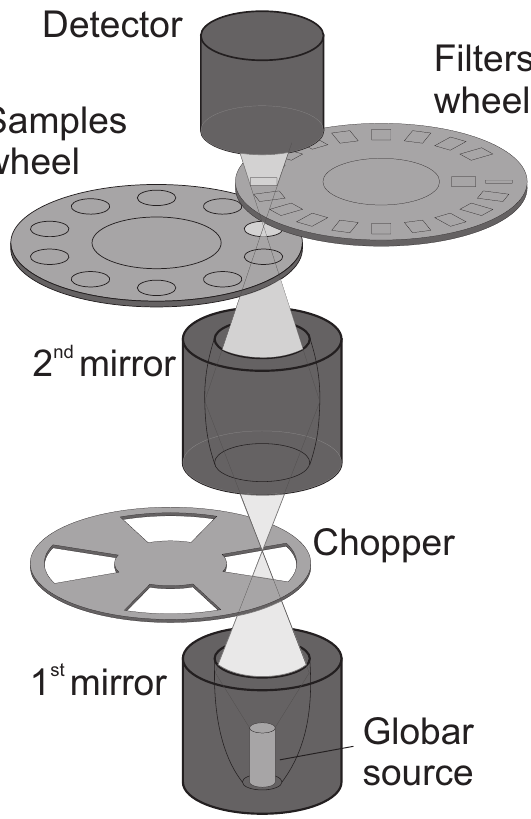
Figure 1. Scheme of the